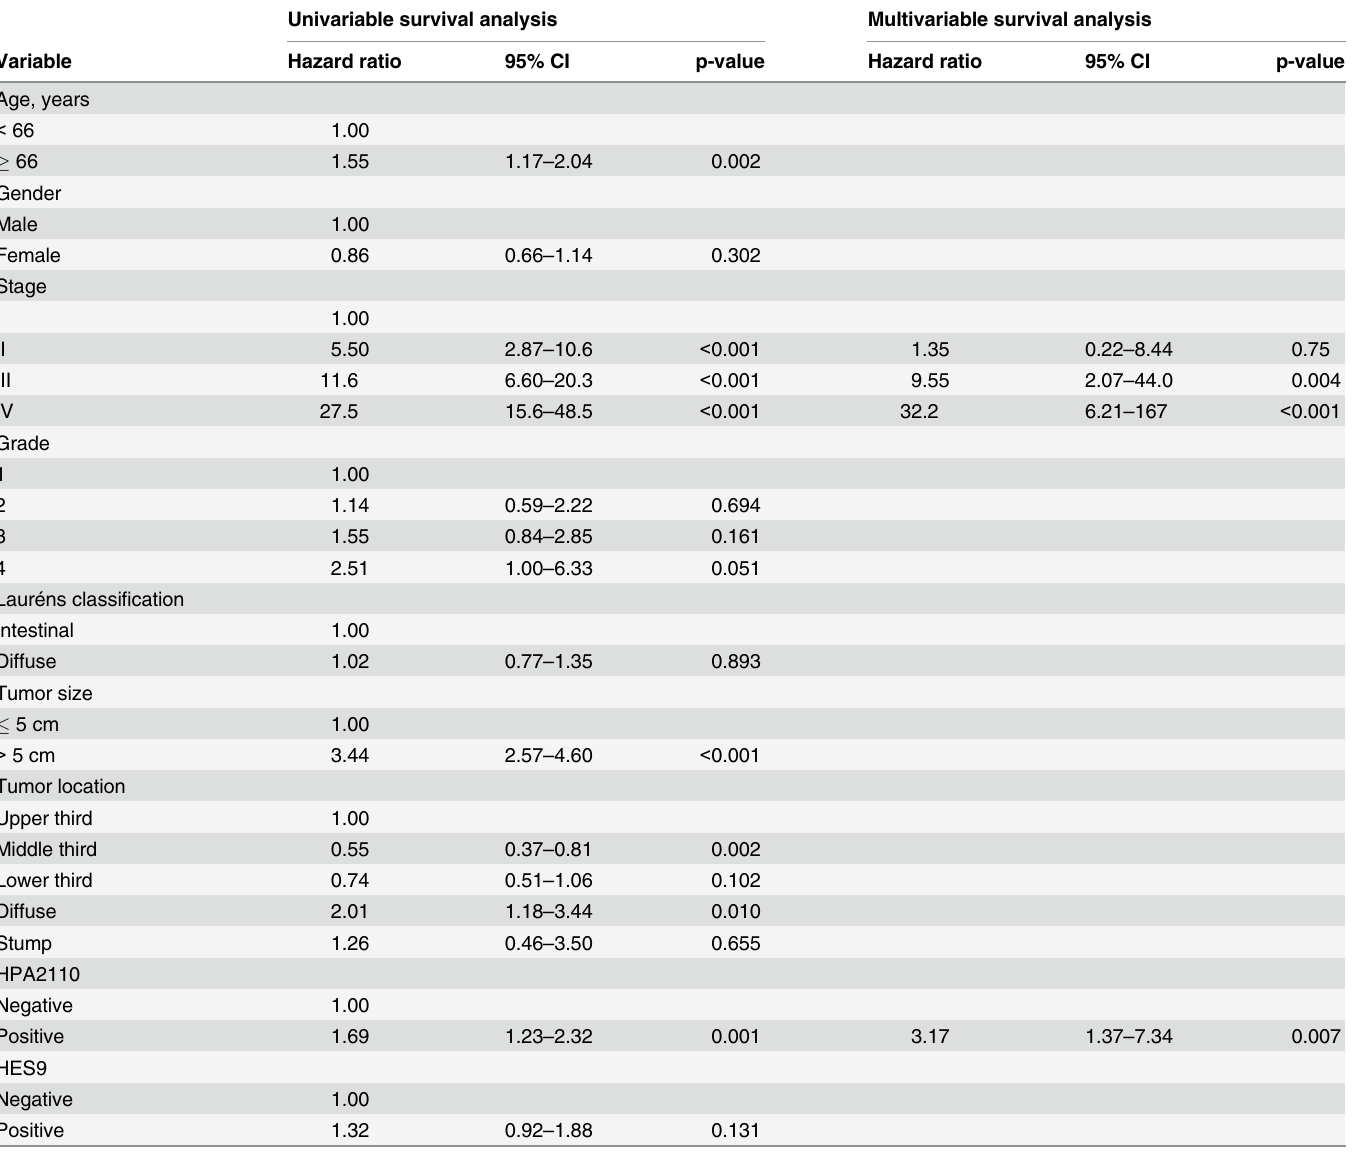
Table 4. Cox regression analysis for disease-specific survival of gastric cancer